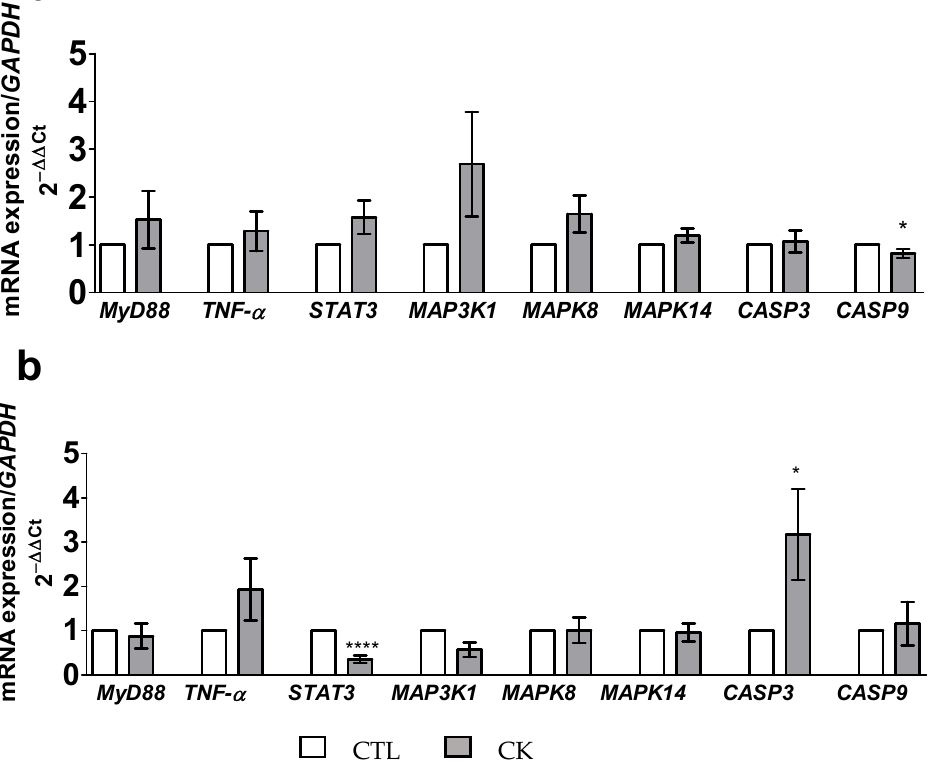
Figure 2. Effect of a 6 h incubation with the cocktail of cytokines on the relative mRNA expression of genes coding for the pro-inflammatory and pro-apoptotic signaling pathways measured by qPCR from the Caco-2/TC7 mono-culture ( a ) and from the Caco-2/TC7 and HT29-MTX co-culture ( b ). Data are expressed as the mean ± SEM ( n = 12). mRNA levels are expressed as fold induction over the CTL group set at 1. *, **** statistically significant difference vs. CTL ( p < 0.05; p < 0.0001, respectively). CK, cytokines; CTL, control; CASP3 , Caspase 3; CASP9 , Caspase 9; MAP3K1 , mitogen-activated protein kinase kinase kinase 1; MAPK8 , mitogen-activated protein kinase 8; MAPK14 , mitogen-activated protein kinase 14, also known as p38-α; MyD88 , myeloid differentiation primary response gene 88; STAT3 , signal transducer and activator of transcription 3; TNF-α , tumor necrosis factor α.